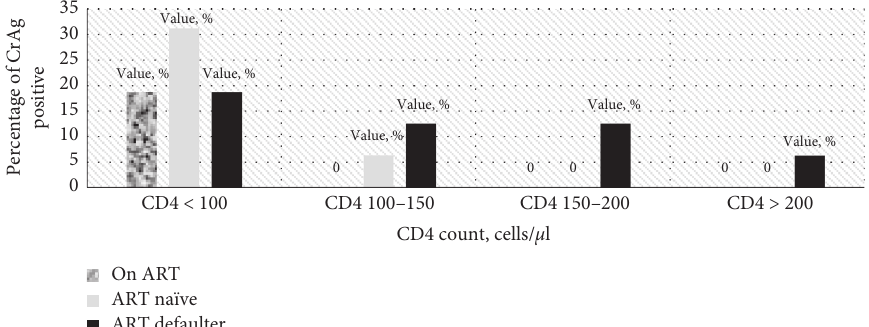
Figure 1: Percentage of cryptococcal antigen positive HIV/AIDS patients associated with CD4 count and ART